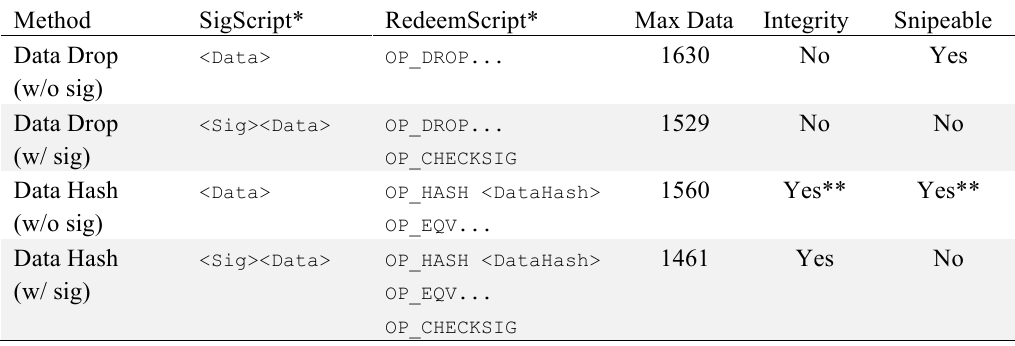
Table 2. P2SH-based Data Insertion Method Summary (Single